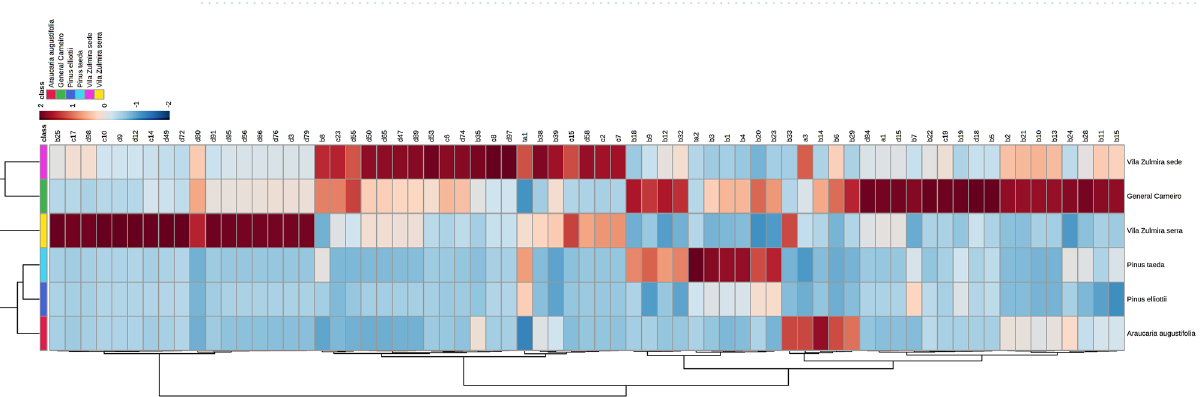
Figure 2. Hierarchical clustering heatmap of chromatograms obtained by SHS-GCMS from brown propolis and conifer resins from southern Brazil. Each colored cell on the heatmap indicates the correlation coefficient, and the scale code is shown on the top right corner (red and blue colors mean positive and negative correlations, respectively, at a level of confidence of 95%). General Carneiro, ‘Vila Zulmira sede’ and ‘Vila Zulmira serra’ refer to the origin of the propolis samples and Araucaria angustifolia , Pinus taeda and Pinus elliotti refer to the plant from where the resins were collected. Codes refer to volatiles shown in Supplementary Tables S1, S2 and S3. Figure was generated by the MetaboAnalyst software, v. 5.0 (https:// www. metab oanal yst.